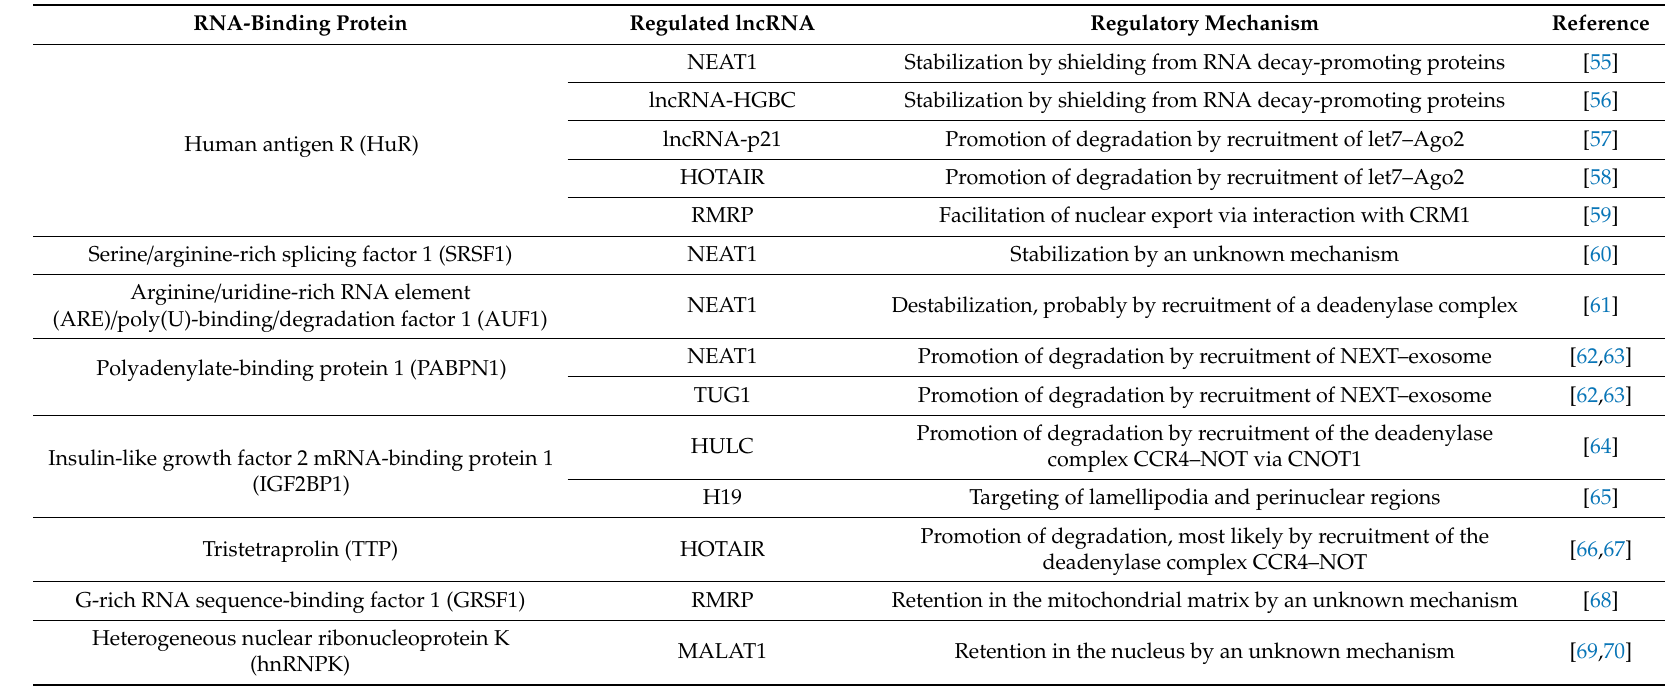
Table 1. RNA-binding proteins (RBPs) and how they regulate known cancer-associated long non-coding RNAs (lncRNAs). Ago2: argonaute-2; CCR4-NOT: carbon catabolite repressor 4–negative on TATA; CNOT1: CCR4–NOT transcription complex subunit 1; CRM1: chromosomal maintenance 1; HOTAIR: HOX antisense intergenic RNA; HULC: highly up-regulated in liver cancer; lncRNA-HGBC: lncRNA highly expressed in gallbladder carcinoma; MALAT1: metastasis-associated